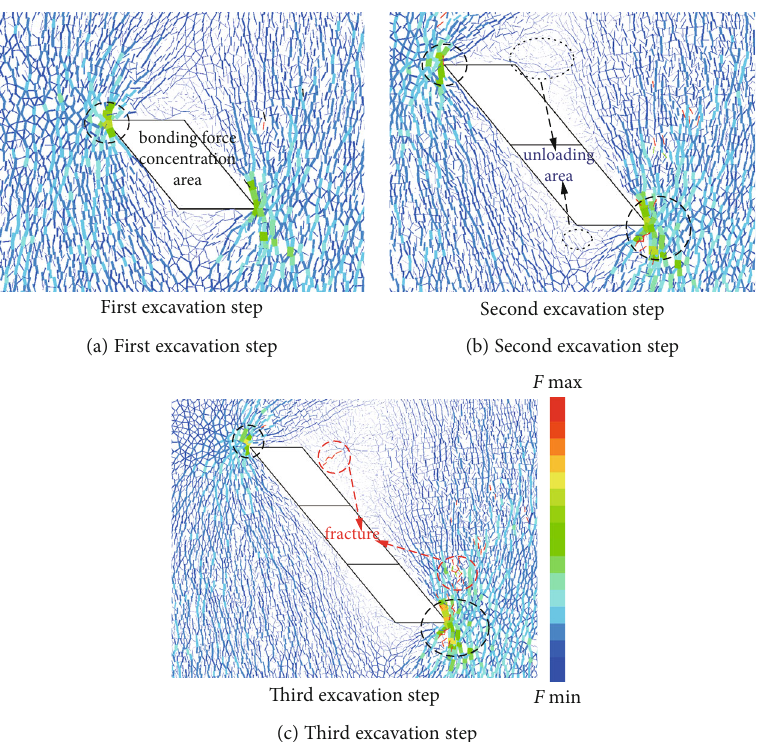
Figure 13: Mesoscale force fi eld distribution and crack propagation during the fi rst, second, and third excavation